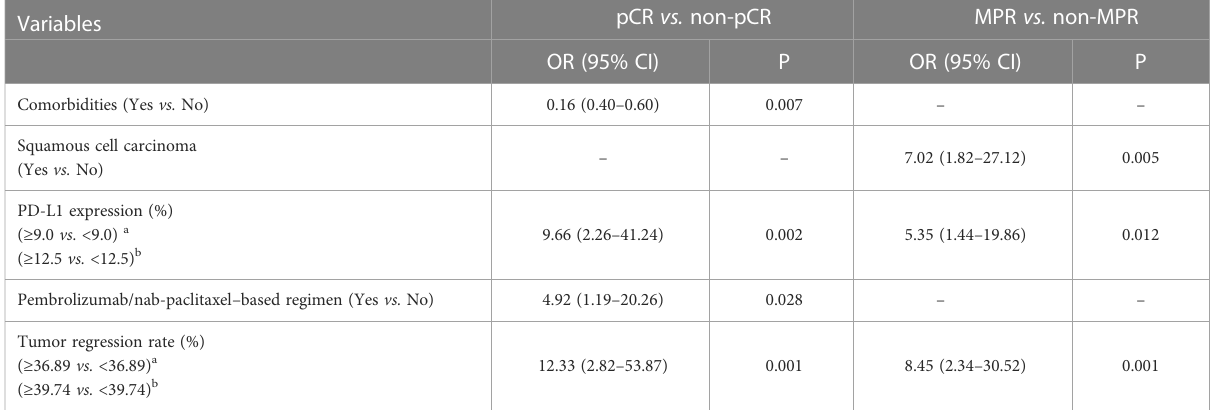
TABLE 6 Multivariate logistic regressions of factors were associated with pCR or MPR. Variables